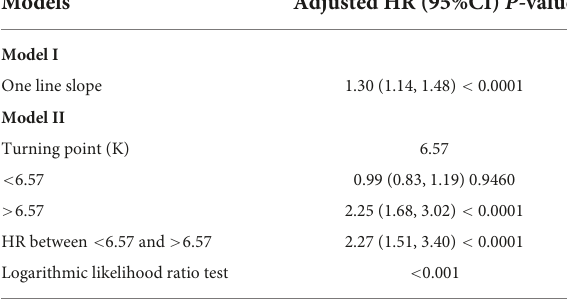
TABLE 3 Threshold analysis for the relationship between ln-SII and all-cause mortality in patients with ASCVD.